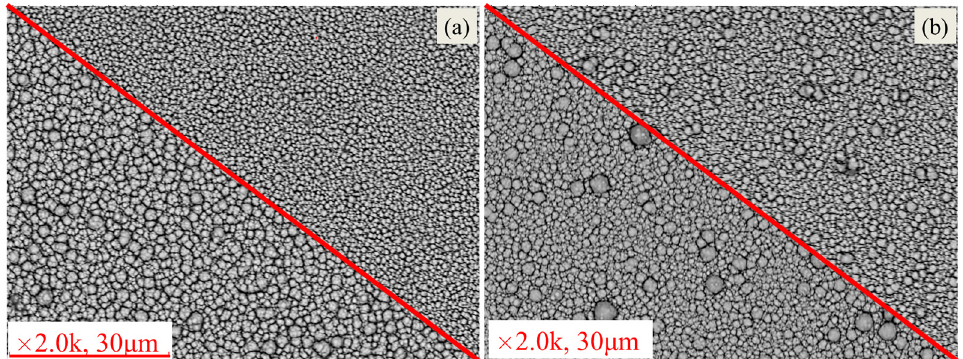
Figure 8. SEM images of the morphology of CIGS thin films prepared at the pressures of 80 kPa (above the red diagonal line) and 3 kPa (below the red diagonal line) and at the potentials of ( a ) − 0.5 V and ( b ) − 0.6 V.